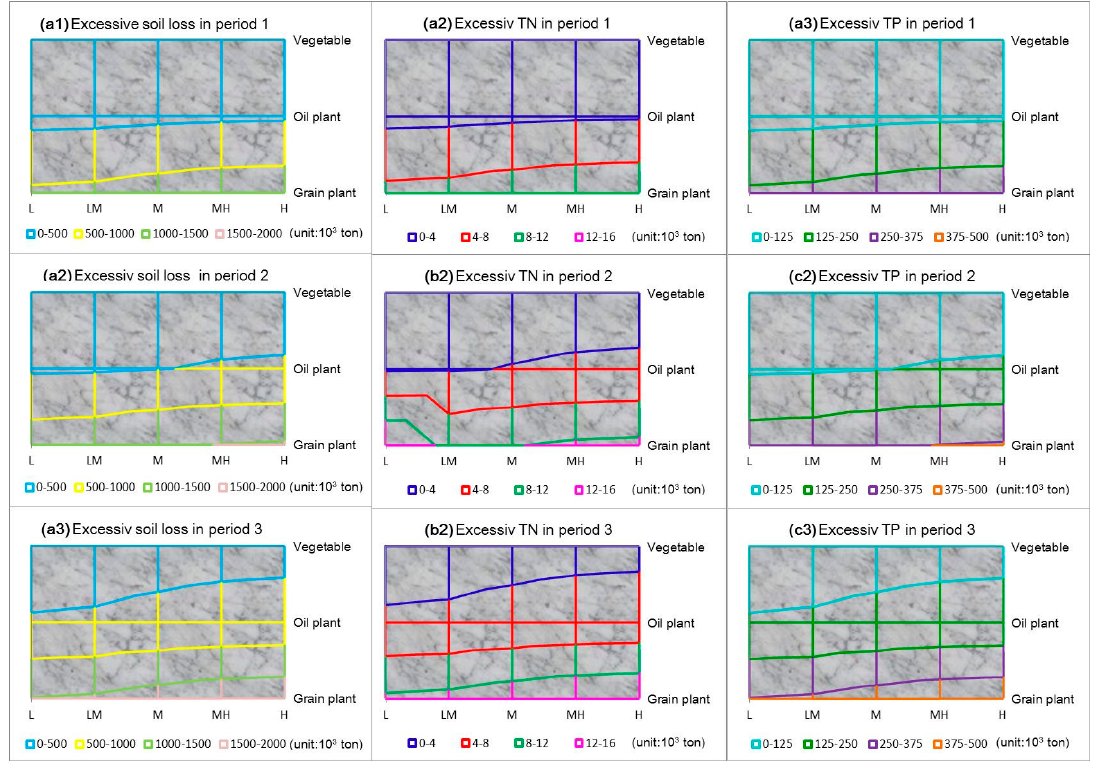
Figure 2. Excessive soil losses and TN/TP discharges from crop irrigation without ecological effect under case 1 when µ are 0.6.